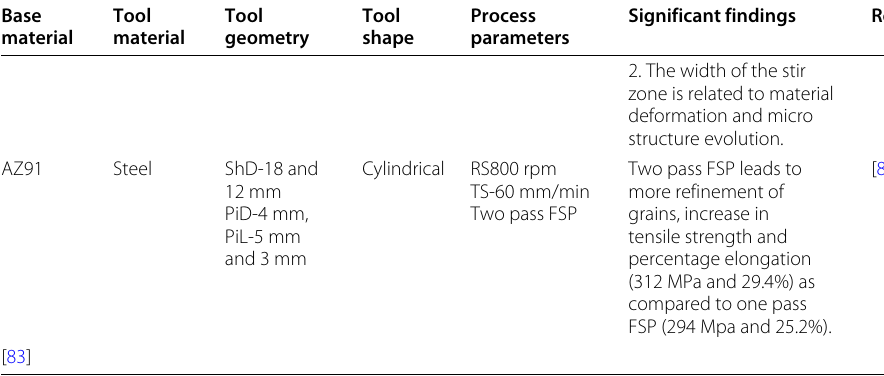
Table 2 Brief summary of surface modification of Mg-AZ system alloys by FSP available in the literature ( Continued